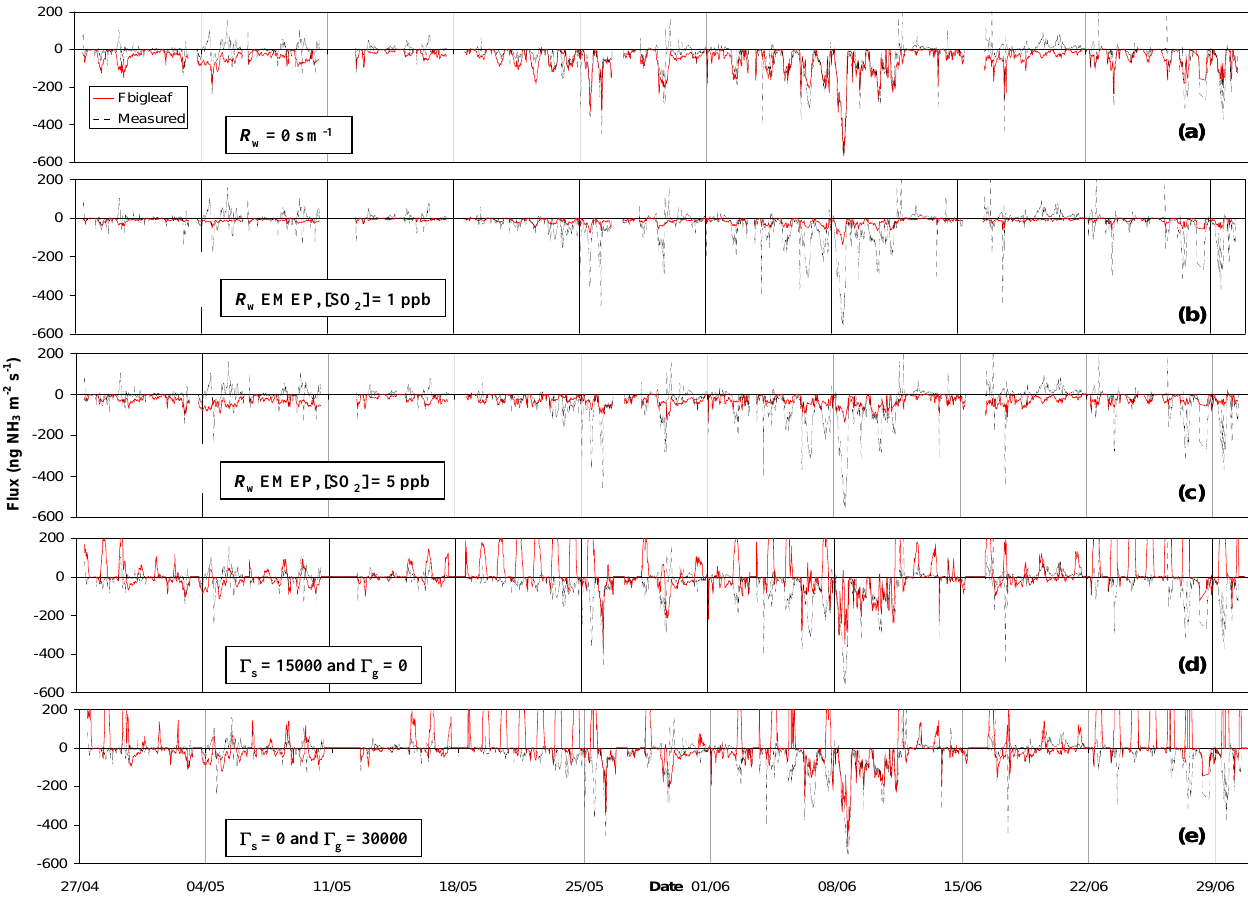
Figure 11. Sensitivity analysis of the Surfatm-NH 3 model to the cuticular resistance, the soil ( Γ g ) and stomatal ( Γ s ) emission potentials. From top to bottom: (a) R w = 0 s m -1 , (b) R w from EMEP-03 with [SO 2 ] = 1 ppb, (c) R w from EMEP-03 with [SO 2 ] = 5 ppb, (d) R w fitted and Γ s = 15000 and Γ g = 0, (e) R w fitted and Γ s = 0 and Γ g = 30000. If not otherwise stated, R w (fitted) = 0.025 exp ((100 - RH ( z 0 )) / 7 ) and Γ s = Γ g = 0.